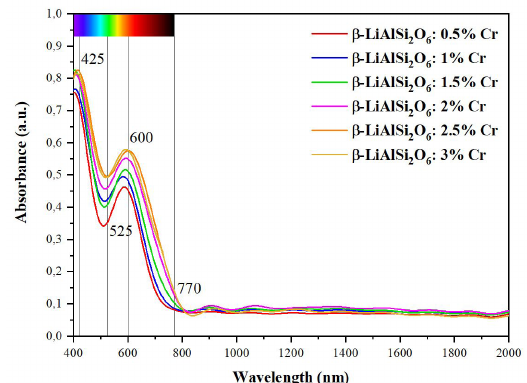
Figure 4. Vis-NIR absorption spectra of β-LiAlSi